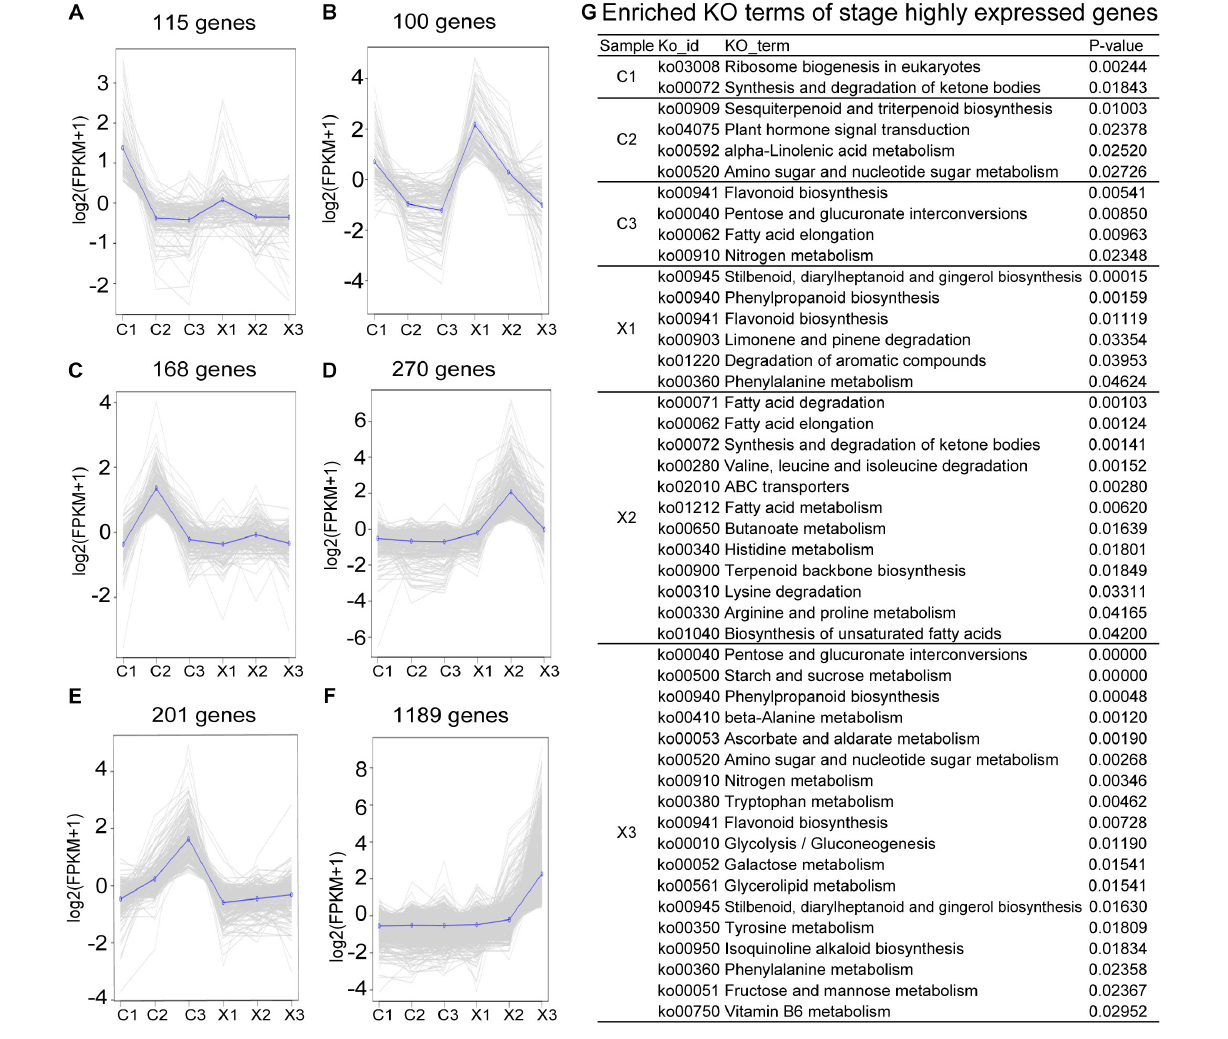
( AGL11 ), and petal development controlling gene, AGL32 were also included in C3 ( Supplementary Table S3 ). In X3, the 1189 specific genes were mainly enriched in 18 pathways, including pentose and glucuronate interconversions (ko00040), starch and sucrose metabolism (ko00500), and phenylpropanoid biosynthesis (ko00940), etc. ( Figure 3G